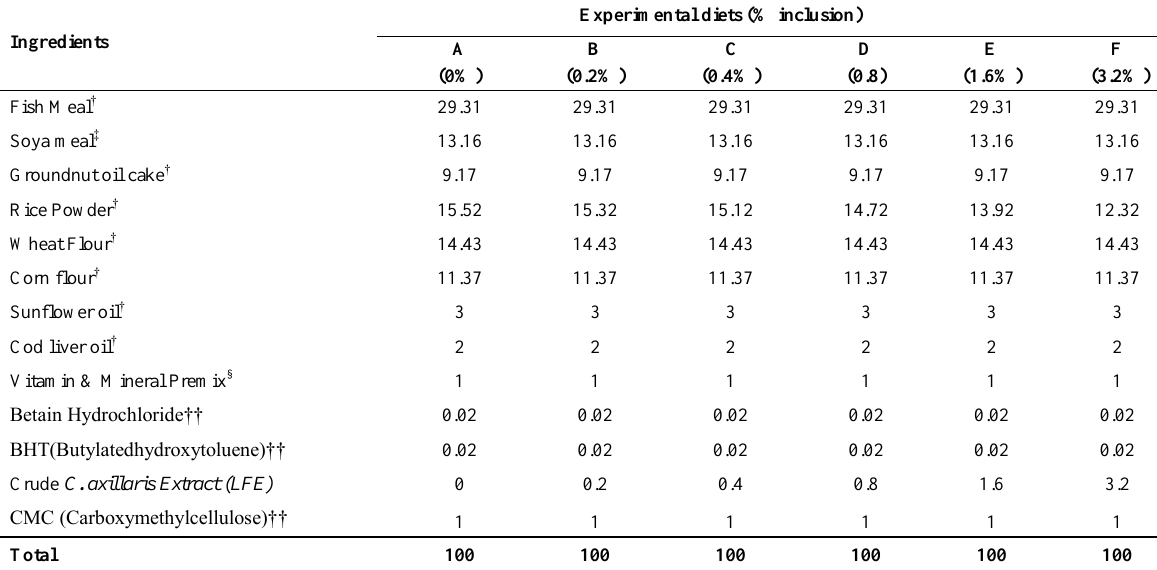
Figure 1. Lapsi fruits are displayed in the market Table 1. Percentage of the experimental diets containing supplement of different levels of Choerospondias axillaris (Lapsi fruit extract) (LFE) and proximate